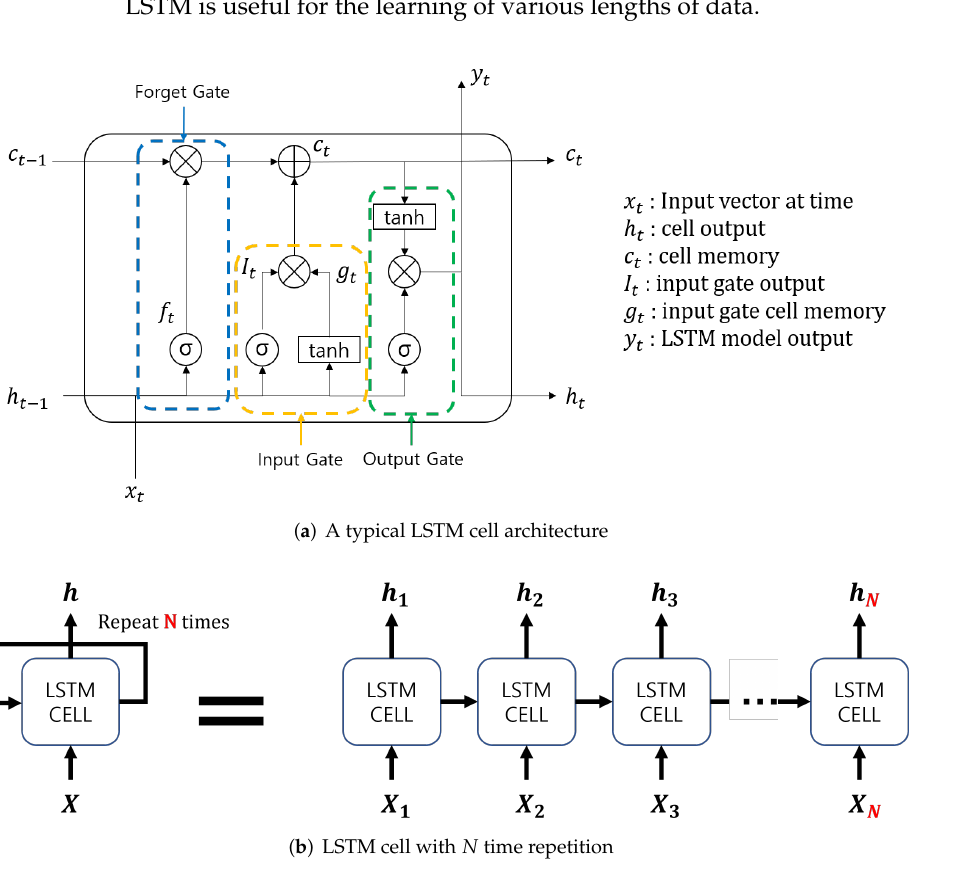
Figure 4. General LSTM